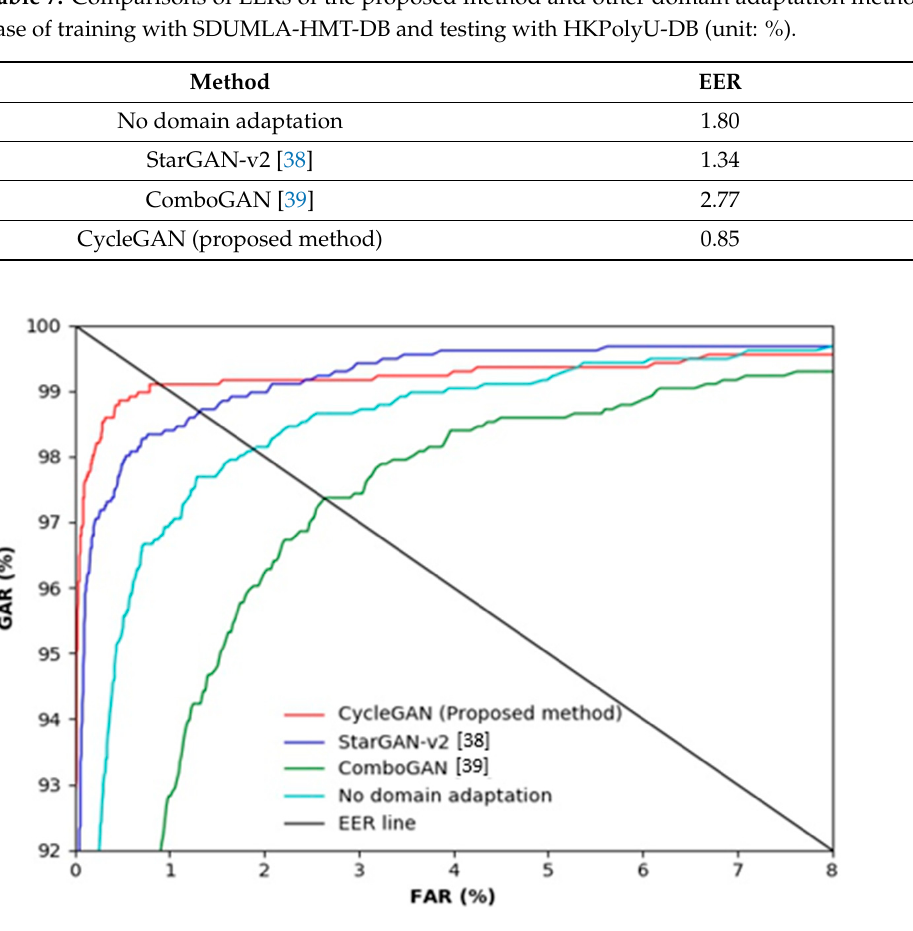
Figure 8. ROC curves of finger-vein recognition by the proposed method and other methods in case of training with the SDUMLA-HMT database and testing with the HKPolyU database.